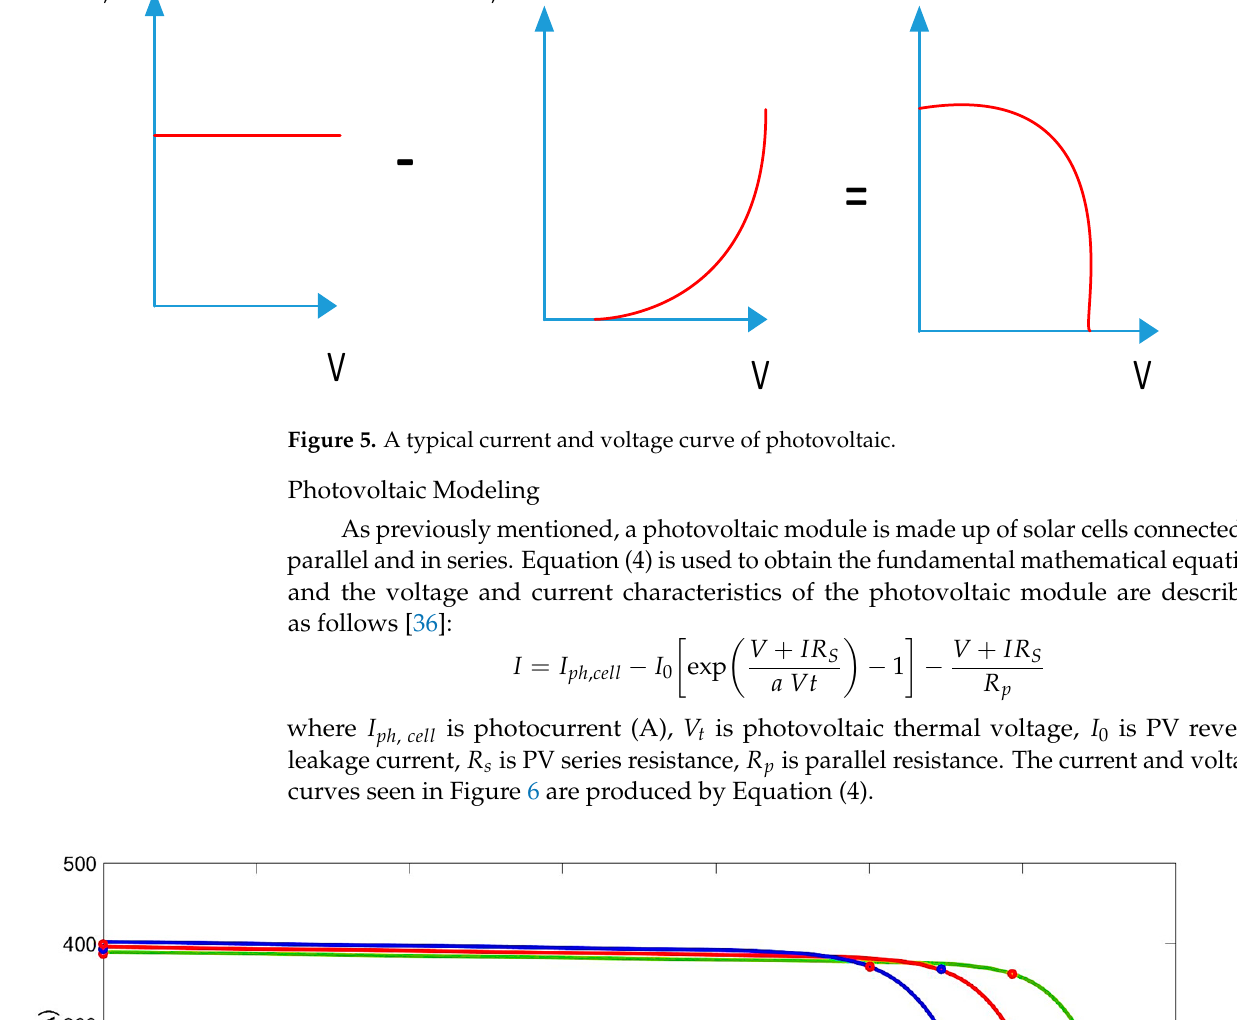
Figure 4. The PV cell’s equivalent circuit [35].